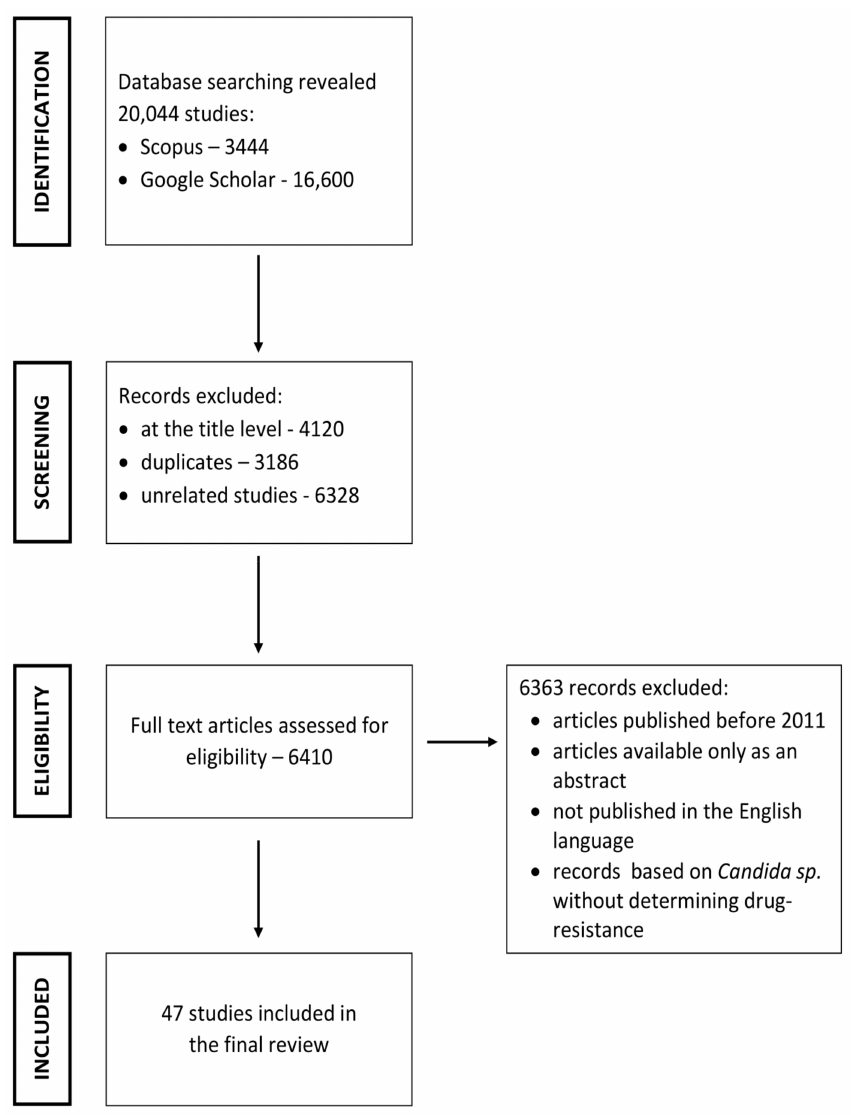
Figure 1. Search strategy used to identify relevant